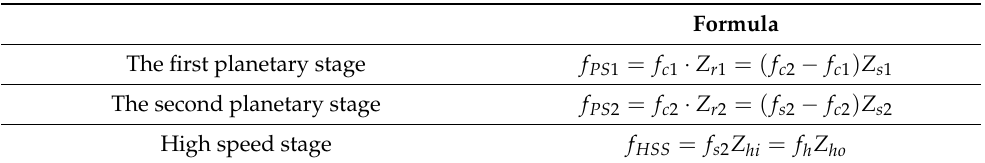
Table 3. Mesh frequencies of different stages in the gearbox with two planetary stages and one parallel stage.